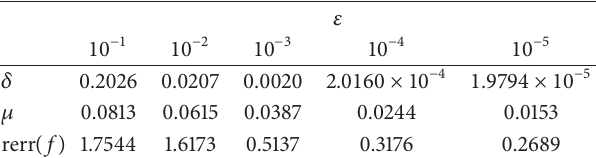
Table 3: 𝛿 , 𝜇 and the relative error rerr( 𝑓 ) with 𝑘 = 2 , 𝑝 = 3 and 𝜇 = (𝛿/𝐸) 1/5 for different 𝜀 .